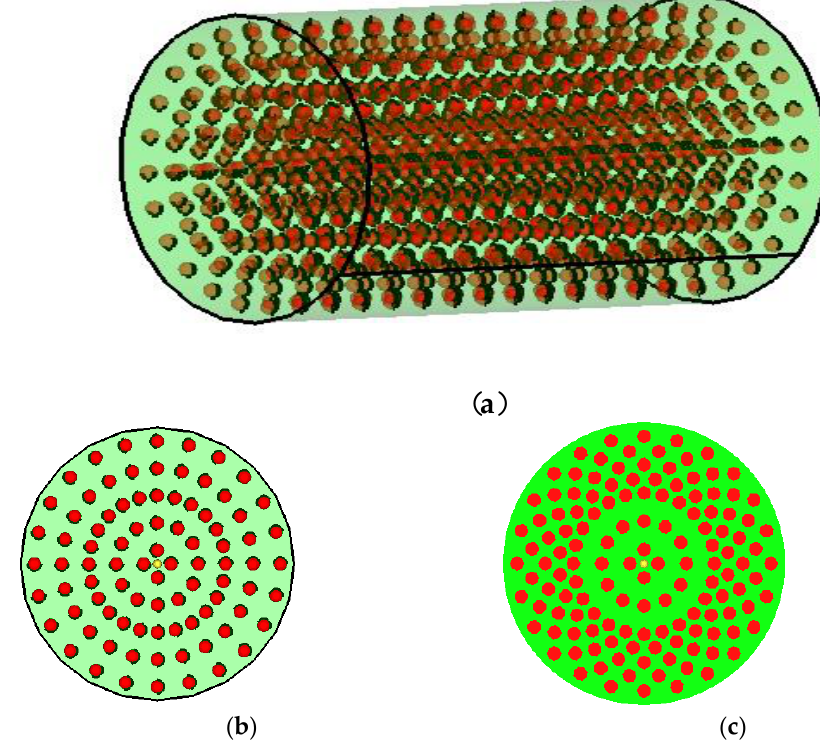
Figure 1. Physical model of the inertial damper. ( a ) Cylinder with balls ( b ) Version I with 1,320 balls. ( c ) Version II with 2040 balls.